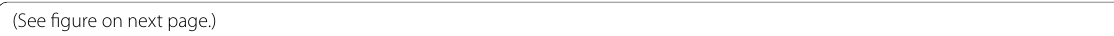
ANOVA)(See figure on next Fig. 7 Phenotypes of GLA 4 as well as osftl4-1 and osftl4-2 mutants under drought conditions. a – c Both mutants ( osftl4-1 and osftl4-2 ) exhibited enhanced drought tolerance. The GLA 4, osftl4-1 , and osftl4-2 seedlings (nearly 40 seedlings per genotype) with regular watering for 14 days a were subjected to drought stress for 4 days b , and recovery for 7 days c , respectively. Scale bars, 5 cm. d Survival rate calculated on the basis of the growth of a new leaf blade after 7 days of re-watering. Error bars represent the SE of three biological replicates (**, p < 0.01, by Student’s t -test). e Water loss rate of detached leaves from the wild-type and mutant lines at different time-points. Data are presented as the mean deviation (n 20). f Stomatal conductance of the wild-type and two mutant lines under normal and drought stress conditions. Error bars represent = three biological replicates (six plants per replicate). g OsNCED4 , OsbZIP23 , and Rab16c expression levels in wild-type and osftl4 plants under normal and drought conditions. Mean values SD were obtained from three technical repeats and three biological repeats. Statistical differences are ± labeled with different letters using LSD test ( p < 0.05, one-way